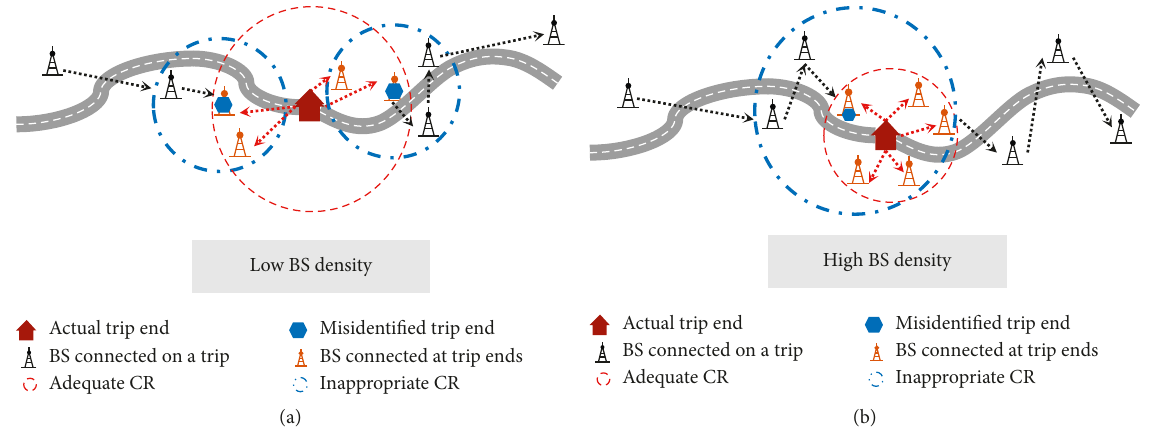
Figure 1: Inappropriate CRs under different BS densities. (a) Too small CR for low BS densities. (b) Too large CR for high BS